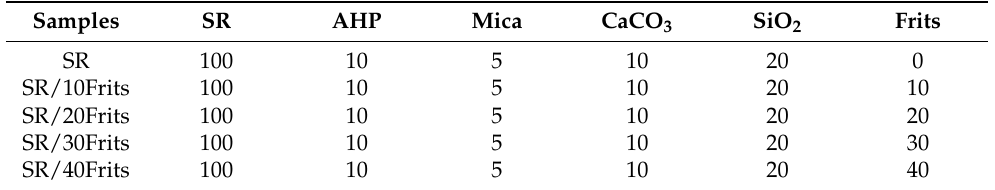
Table 1. Formulations of CSR/frit